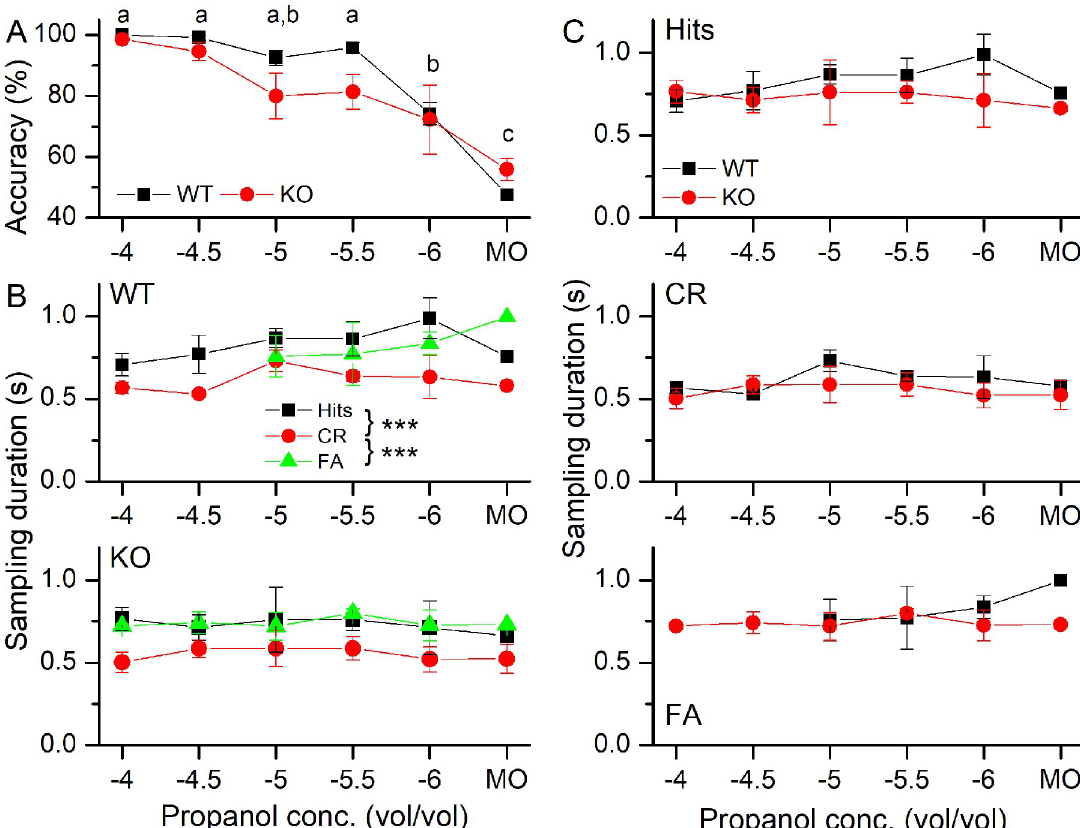
Fig 1. Accuracy and sampling behavior in a Go/NoGo odor-guided experiment in wildtype and NCKX4 knockout mice. A WT and NCKX4 KO mice were exposed to progressively lower propanol concentrations or the control odor mineral oil (MO) to establish their accuracy to distinguish between them. Accuracy has odor concentration as the main factor (F(9,10) = 8.63, p = 0.002), while no differences exist between genotypes. Same letters indicate the absence of significance between concentrations (post-hoc Tukey). B The odor sampling duration as a function of the odorant concentration and Hits, Correct Rejections (CRs) and, False Alarms (FAs) for the WT and the KO. The final model for sampling duration is a linear regression with mouse ID as a random effect and behavioral outcome as the main significant effect (F = 22.346, p = 1.711e -8 ). Post-hoc analysis revealed CRs being significantly less frequent than FAs (p < 0.0001) and Hits (p < 0.0001). C Comparison of the three behavioral outcomes between WT and KO. Data points are averages ± SEM of 3 WT and 3 KO mice. The x-axis displays the log of the odorant